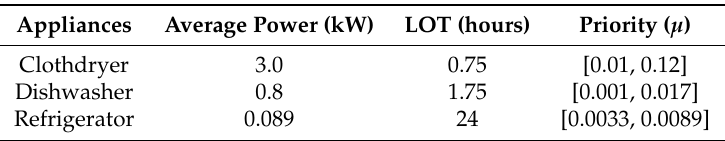
Table 5. Parameters of